Question: What style of plot is this figure drawn as?
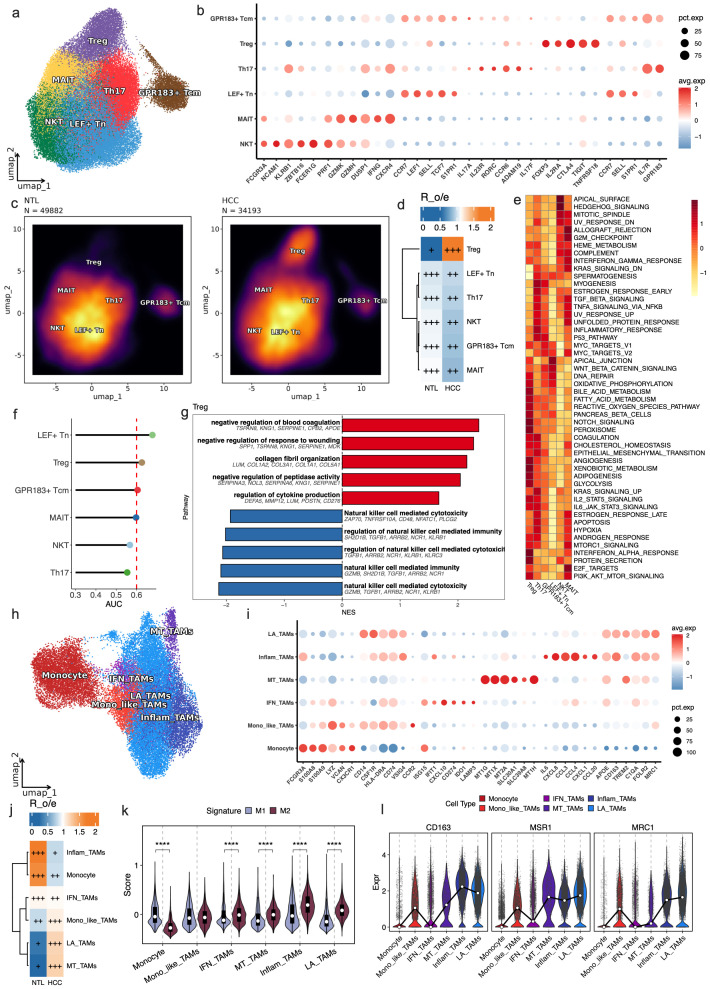
Answer: heatmap